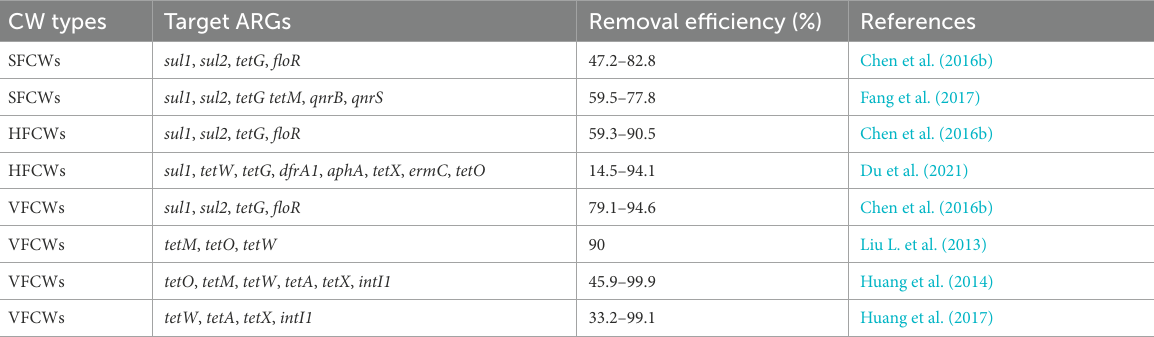
TABLE 1 ARGs removal effects in different